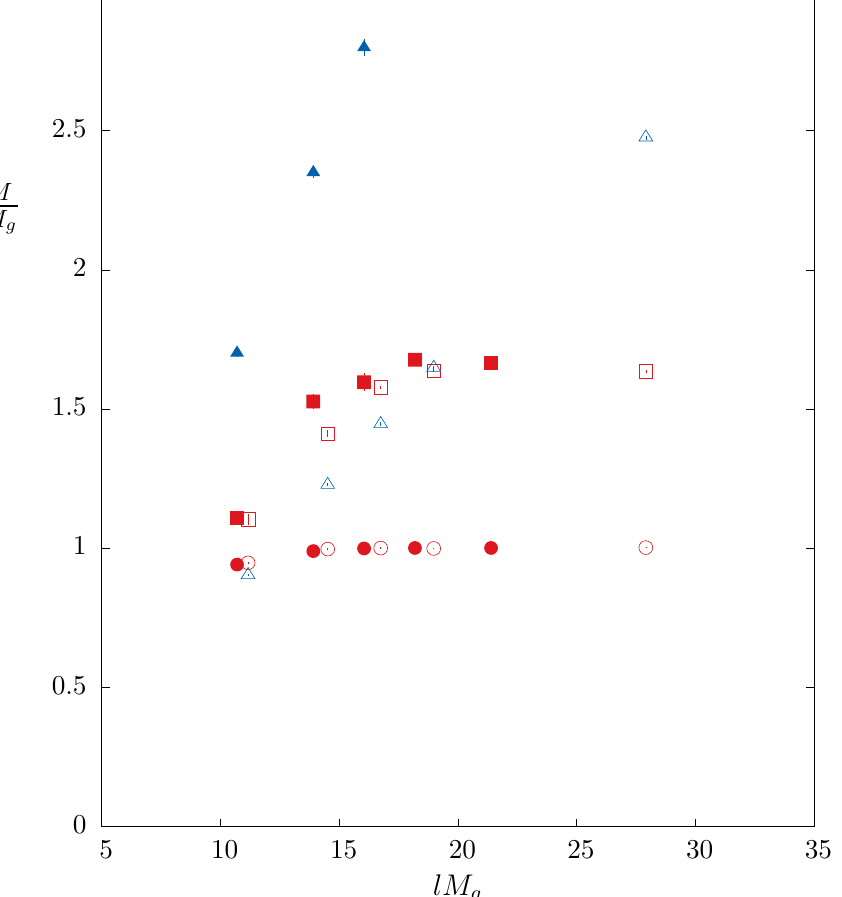
= (cid:27) SU4 ’ 1 : 35 (cid:27) SU2 f k =2 k